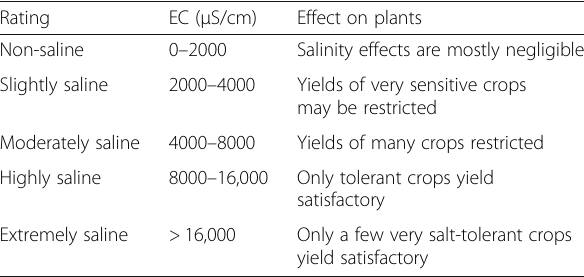
Table 5 Salinity ratings for soil based on electric